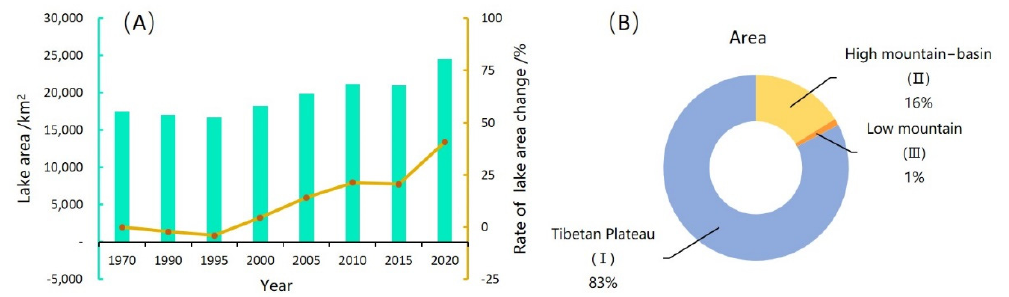
Figure 2. Characteristics of lakes in CEA over the past 50 years. ( A ) Change characteristics of total lake area in CEA over the past 50 years; ( B ) Area proportions of lakes in the Tibetan Plateau, high mountain—basin, and low mountain zones, respectively.